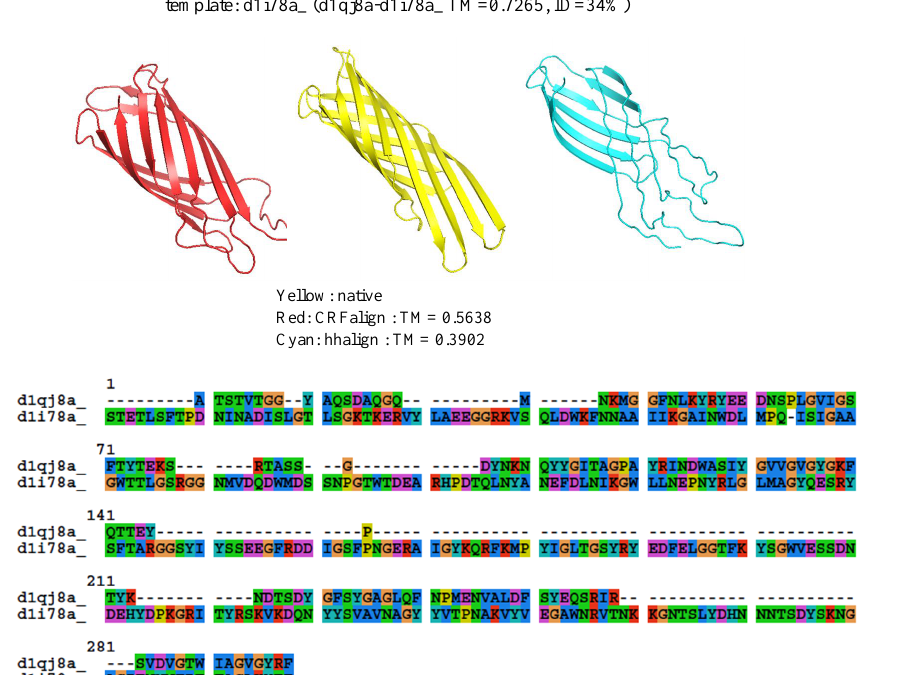
Figure 7. Structure models of d1qj8a (The Outer Membrane Protein OMPX from E. Coli) based on d1qj8a-d1i78a_ alignment ( Reference TM = 0.7265, ID = 3.4%) from CRFalign ( top left , red) with TM-CRFalign = 0.5638, and HHalign ( top right , cyan) with TM-HHalign = 0.3902; at the top center (yellow) is the native structure. At the bottom is shown the CRFalign alignment where also a large gap is